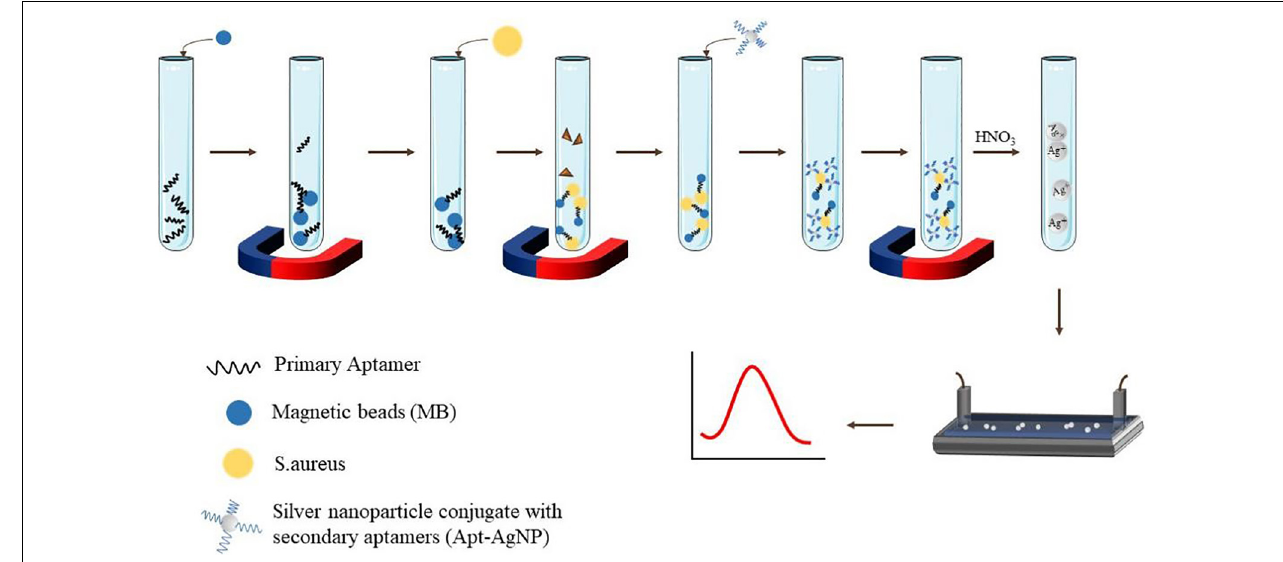
FIGURE 3 | Schematic display electrochemical dual aptamer sandwich detection of S. aureus .